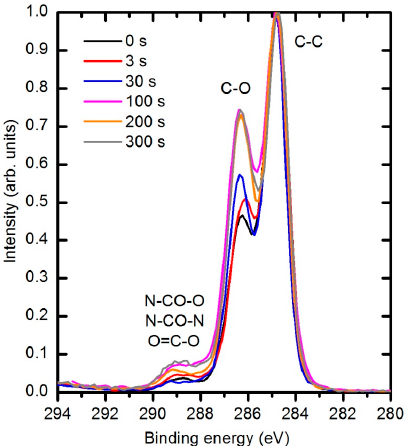
Figure 18. Evolution of XPS C1s spectra for PURPEG samples as a result of treatment with oxygen plasma at 33 Pa and 150 W.